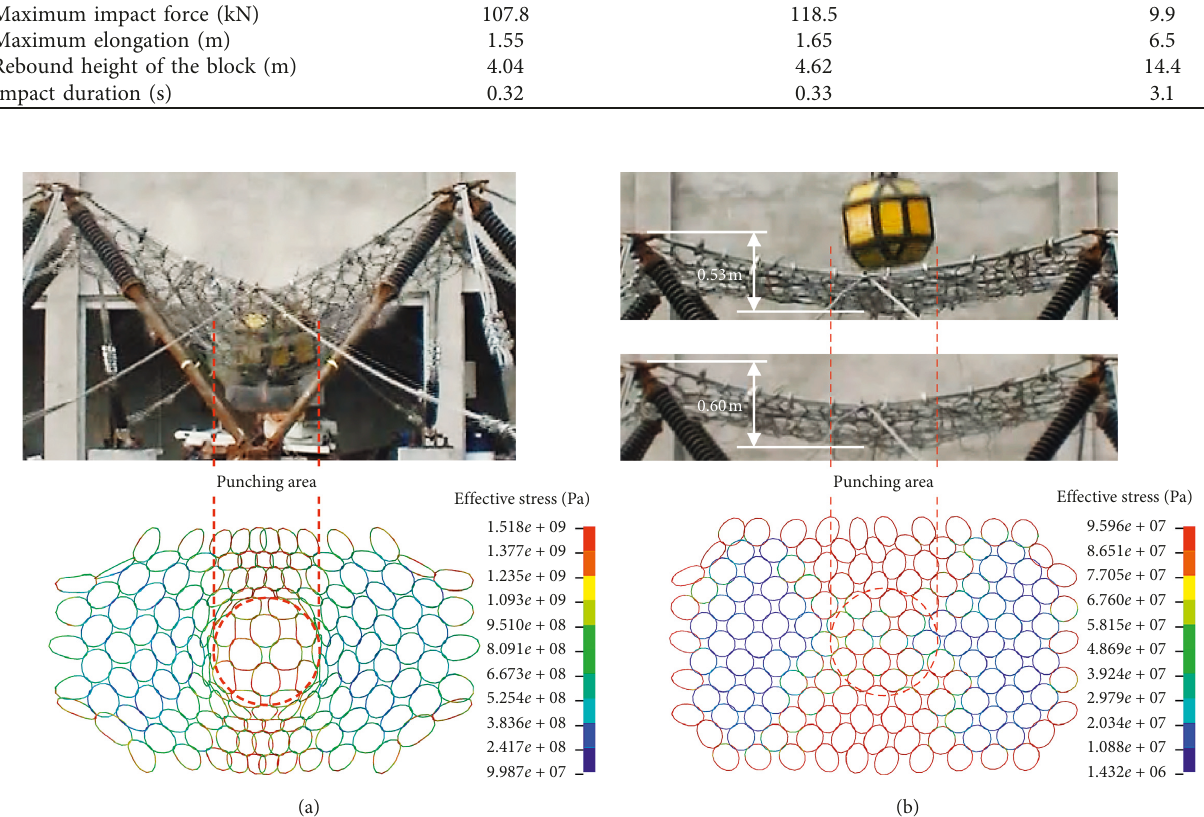
Figure 15: Resilience of the ring nets. (a) Maximum impact. (b) Comparison before and after impact.